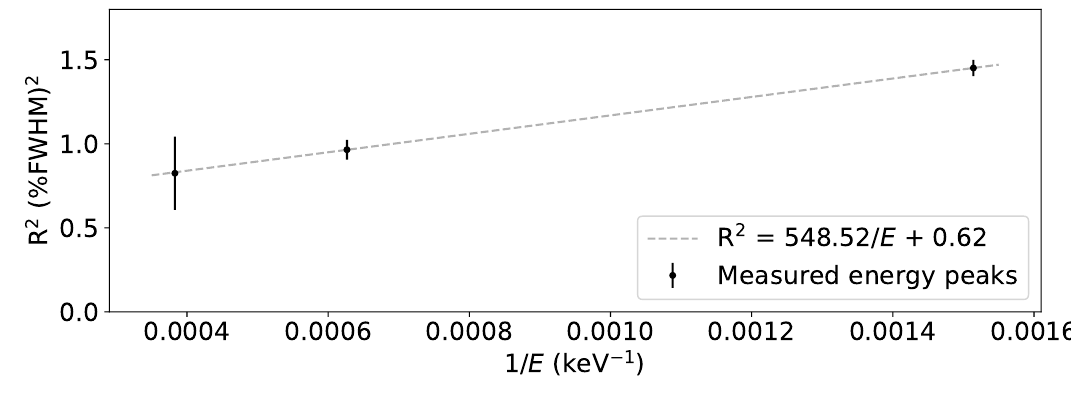
Figure 7 . Squared energy resolution plotted against 1 =E . The measured points were (cid:12)t to the functional form R 2 = a=E + c , with a = 548 : 52 (cid:6) 82 : 15 %FWHM 2 (cid:1) keV and c = 0 : 62 (cid:6) 0 : 10 %FWHM 2